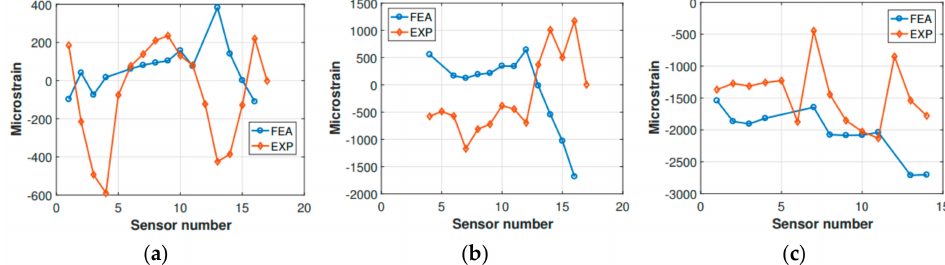
Figure 16. Experimental (EXP) vs. FEA strain comparison for ( a ) frame 7, ( b ) frame 10, and ( c ) tail